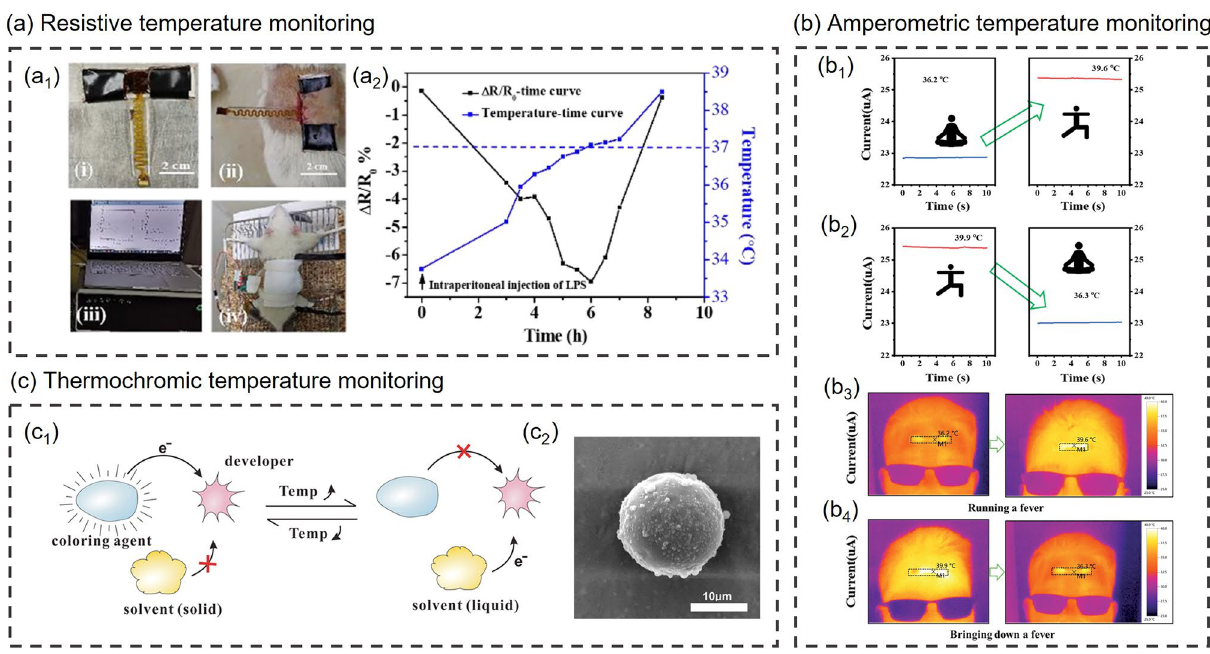
Fig. 10 a Resistive temperature monitoring [179]. a 1 Operational procedures during the implantation of the sensor in LPS-induced fever model mice. a 2 Monitoring of the subcutaneous temperature of mice (blue line), and the corresponding ΔR/R 0 of the sensor (black line) after intraperi- toneal injection of LPS. Reproduced with permission. Copyright 2022, American Chemical Society. b Amperometric temperature monitoring [180]. b 1 , b 2 The current variation of PDRG hydrogel-based temperature sensor before and after the “artificial fever”. b 3 , b 4 Recording volun- teer’s forehead temperature through infrared thermal images of the human forehead before and after the “artificial fever”. Reproduced with